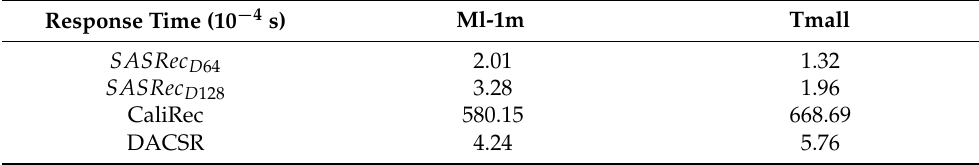
Table 3. Average time consumption for each